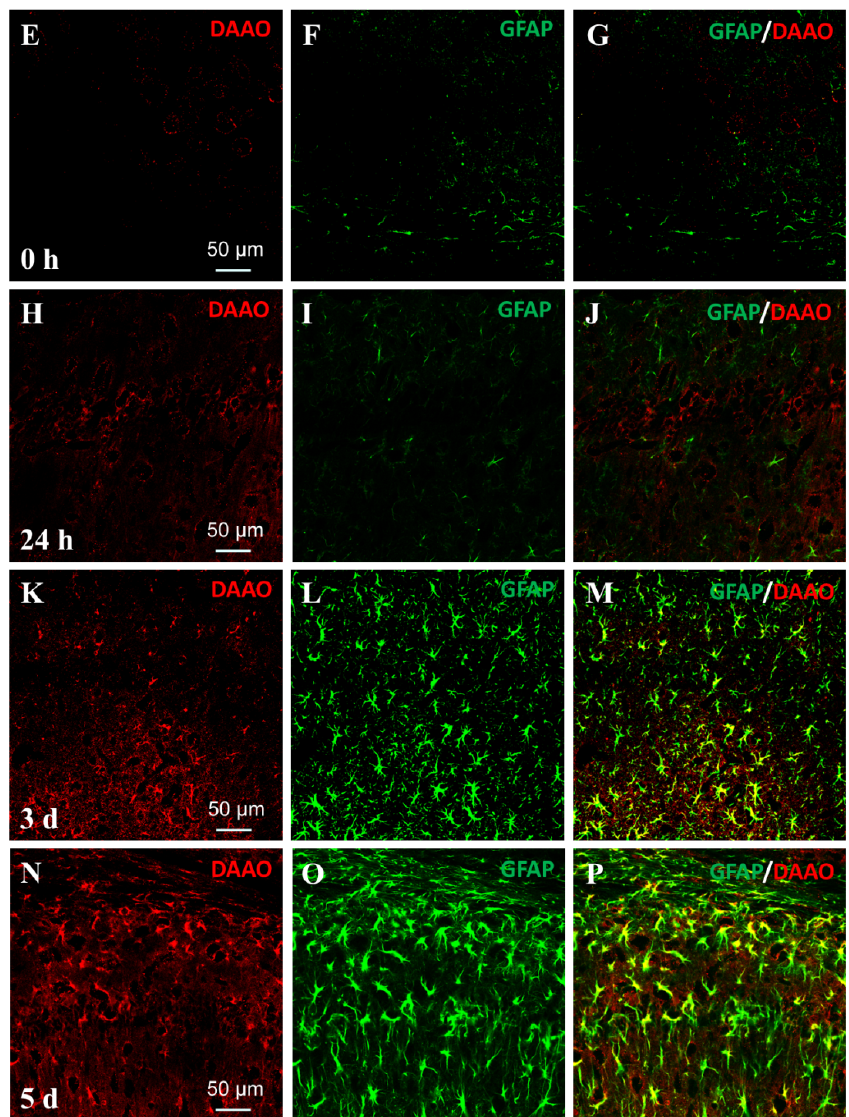
Figure 1. Hippocampal DAAO is mainly expressed in activated astrocytes in ischemic mice induced by transient MCAO. Immunostained DAAO in hippocampal CA2 area is double-labeled with the biomarkers Iba-1 for microglia ( A ), GFAP for astrocytes ( B ), and NeuN for neurons ( C ) on day 3 after ischemic surgery ( n = 3, 0.2 mm × 0.2 mm). Arrows indicate the colocalization of DAAO (red) and cell-specific biomarkers (green). The colocalized area fractions of DAAO with three cellular markers were quantified ( D ). Data are shown as means ± SEM. Double-labeled GFAP/DAAO immunostaining was also colocalized and quantified at four timepoints (0 h, 24 h, 3 days, and 5 days) following MCAO surgery ( E – P